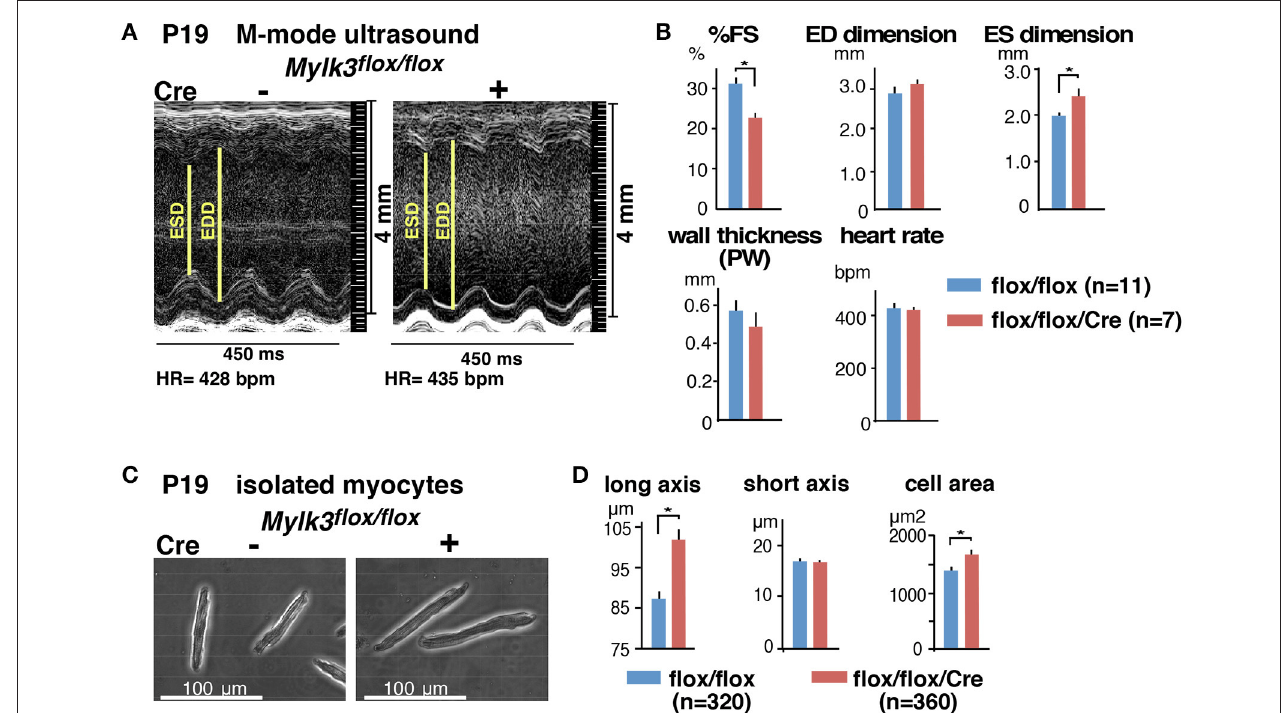
FIGURE 2 | Reduced contractility and elongation of cardiomyocytes in perinatal Mylk3-KO mice. (A) Representative echocardiographic images, and (B) Summary of echocardiographic indices of inducible Mylk3-KO mice and control at P19. (C) Representative images of isolated cardiomyocytes, and (D) summarized data of short- and long axis and cell area size at P19. mean ± SE. * p < 0.05 using T -test. FS, fractional shortening; ED, end-diastolic; ES, end-systolic; PW, posterior wall.